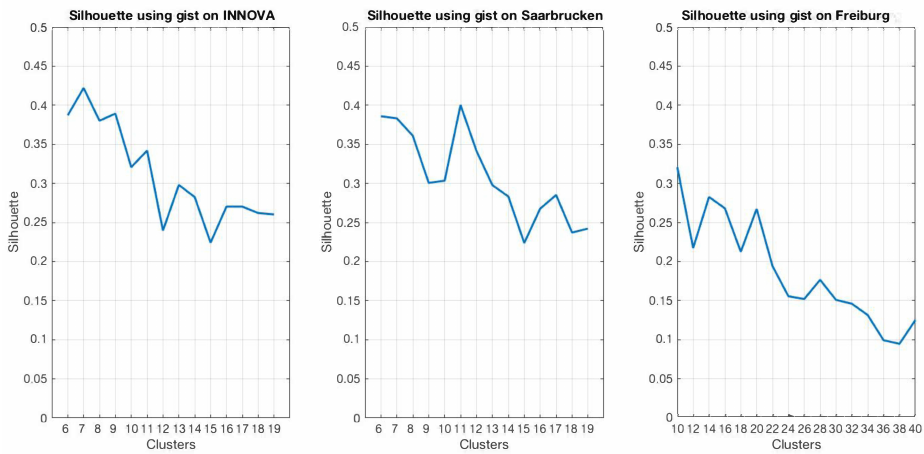
Figure 11. Average silhouette after batch spectral clustering process using HOG versus number of clusters.